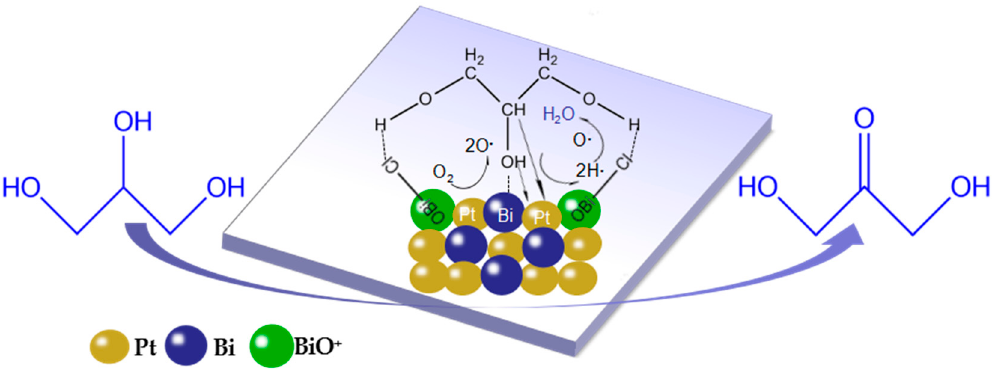
Figure 6. A proposed mechanism for the selective oxidation of glycerol towards DHA over the Pt–Bi/HT system.